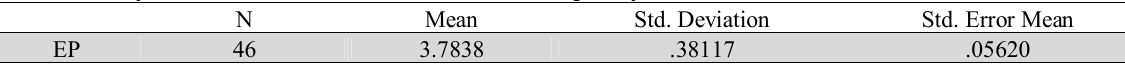
The summary of some basic statistics on execution policy